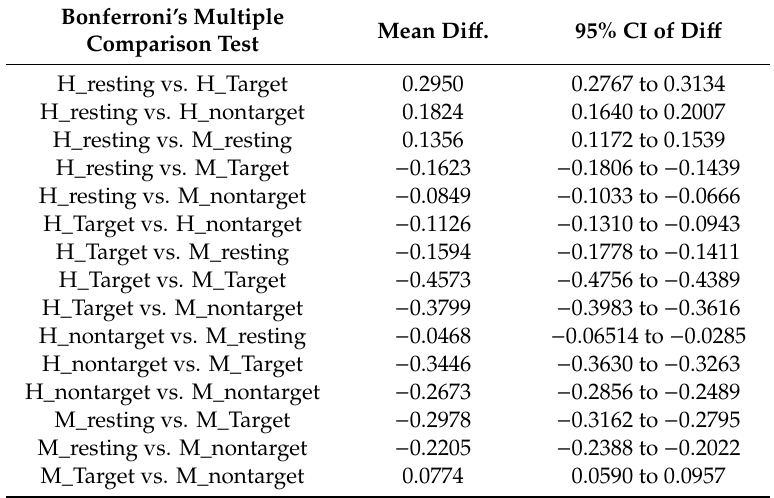
Table 5. One-way ANOVA results of mean differences and its 95% confidence intervals in the approximate entropy among conditions.